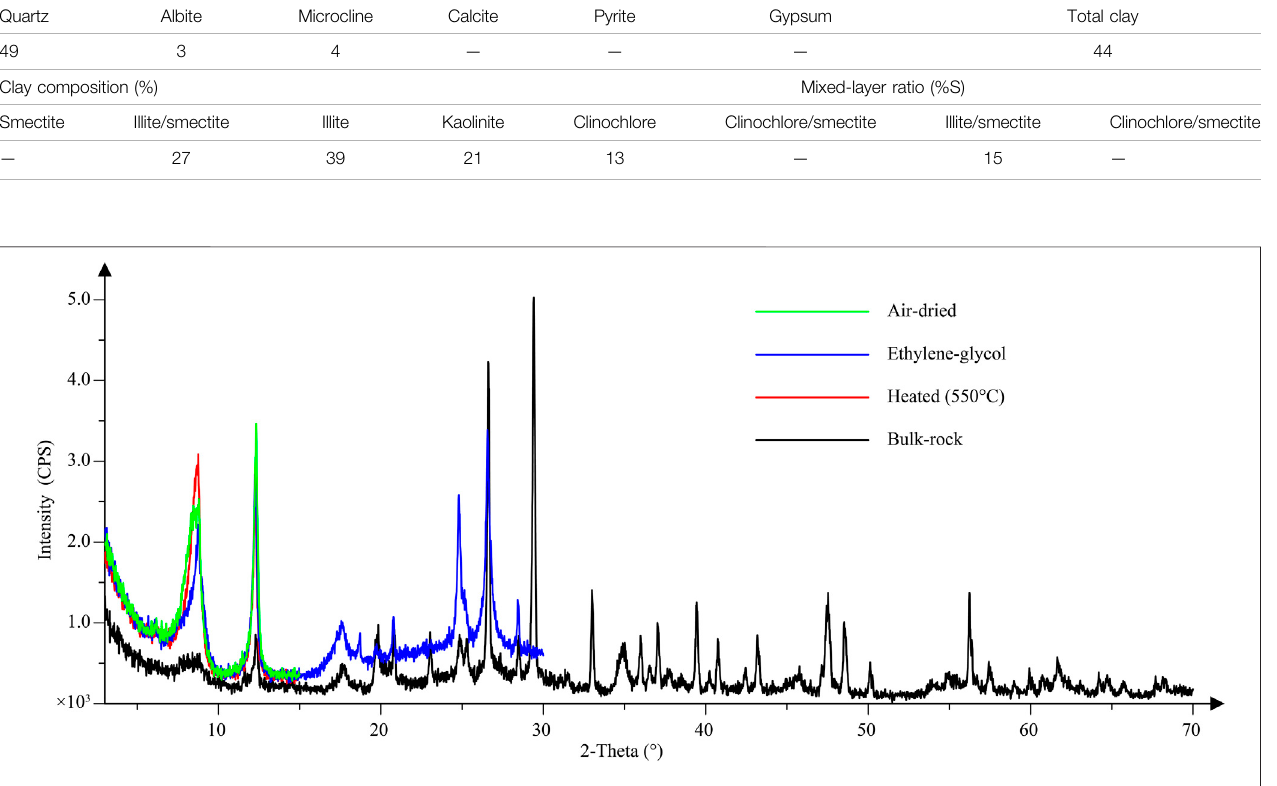
FIGURE 10 | Graph showing the XRD patterns of sample XH4.